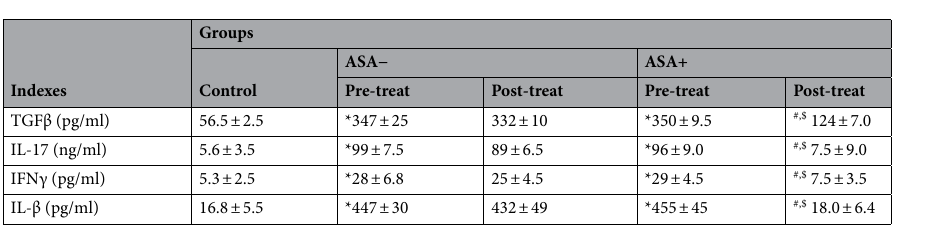
Table 7. The expression levels of TGFβ, IL-17, IFNγ, and IL-β proteins by ELISA assay in response to aspirin consumption in patients with breast cancer. ASA−: Non-aspirin group, ASA+: Aspirin group. *P < 0.05 compared to the control group. # P < 0.05 compared to Pre-treat ASA+. $ P < 0.05 compared to Post-treat